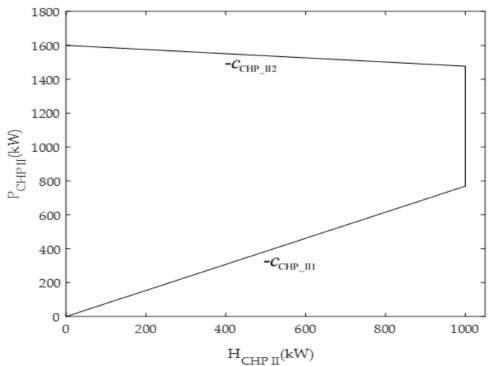
Figure 3. Feasible operation region of CHP unit with variable heat-to-electricity ratio.